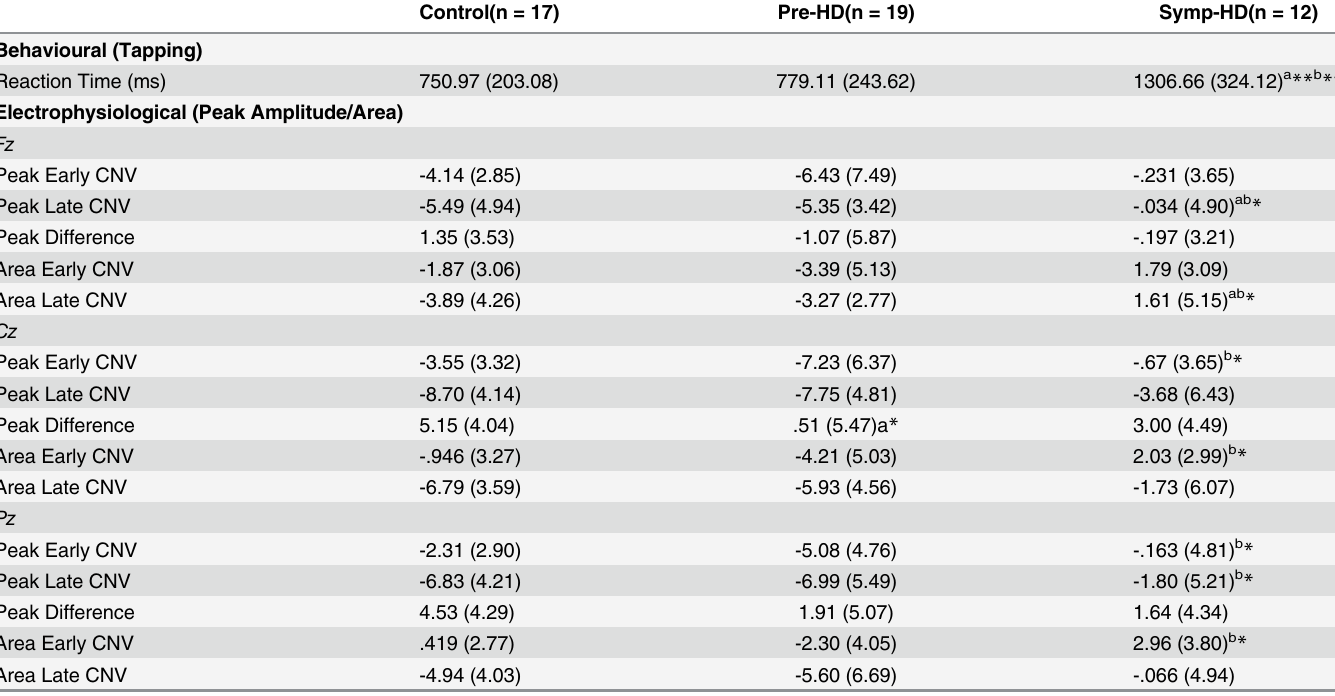
Table 3. Electrophysiological and behavioural results for participants in the Sensorimotor Integration Task 2. Amplitudes of early and late CNV by group at Fz, Cz, and Pz. Standard deviations (SD) provided in